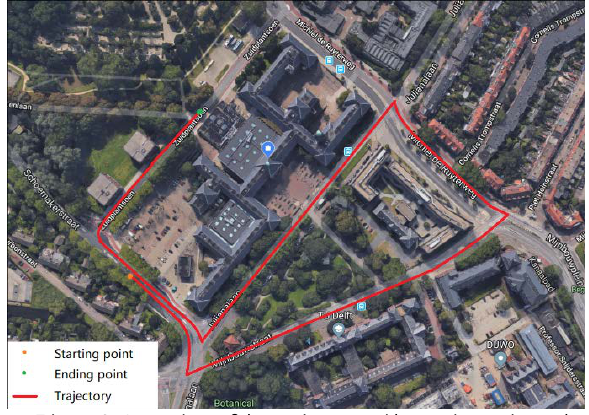
Figure 8. Overview of the trajectory with starting point and ending point.